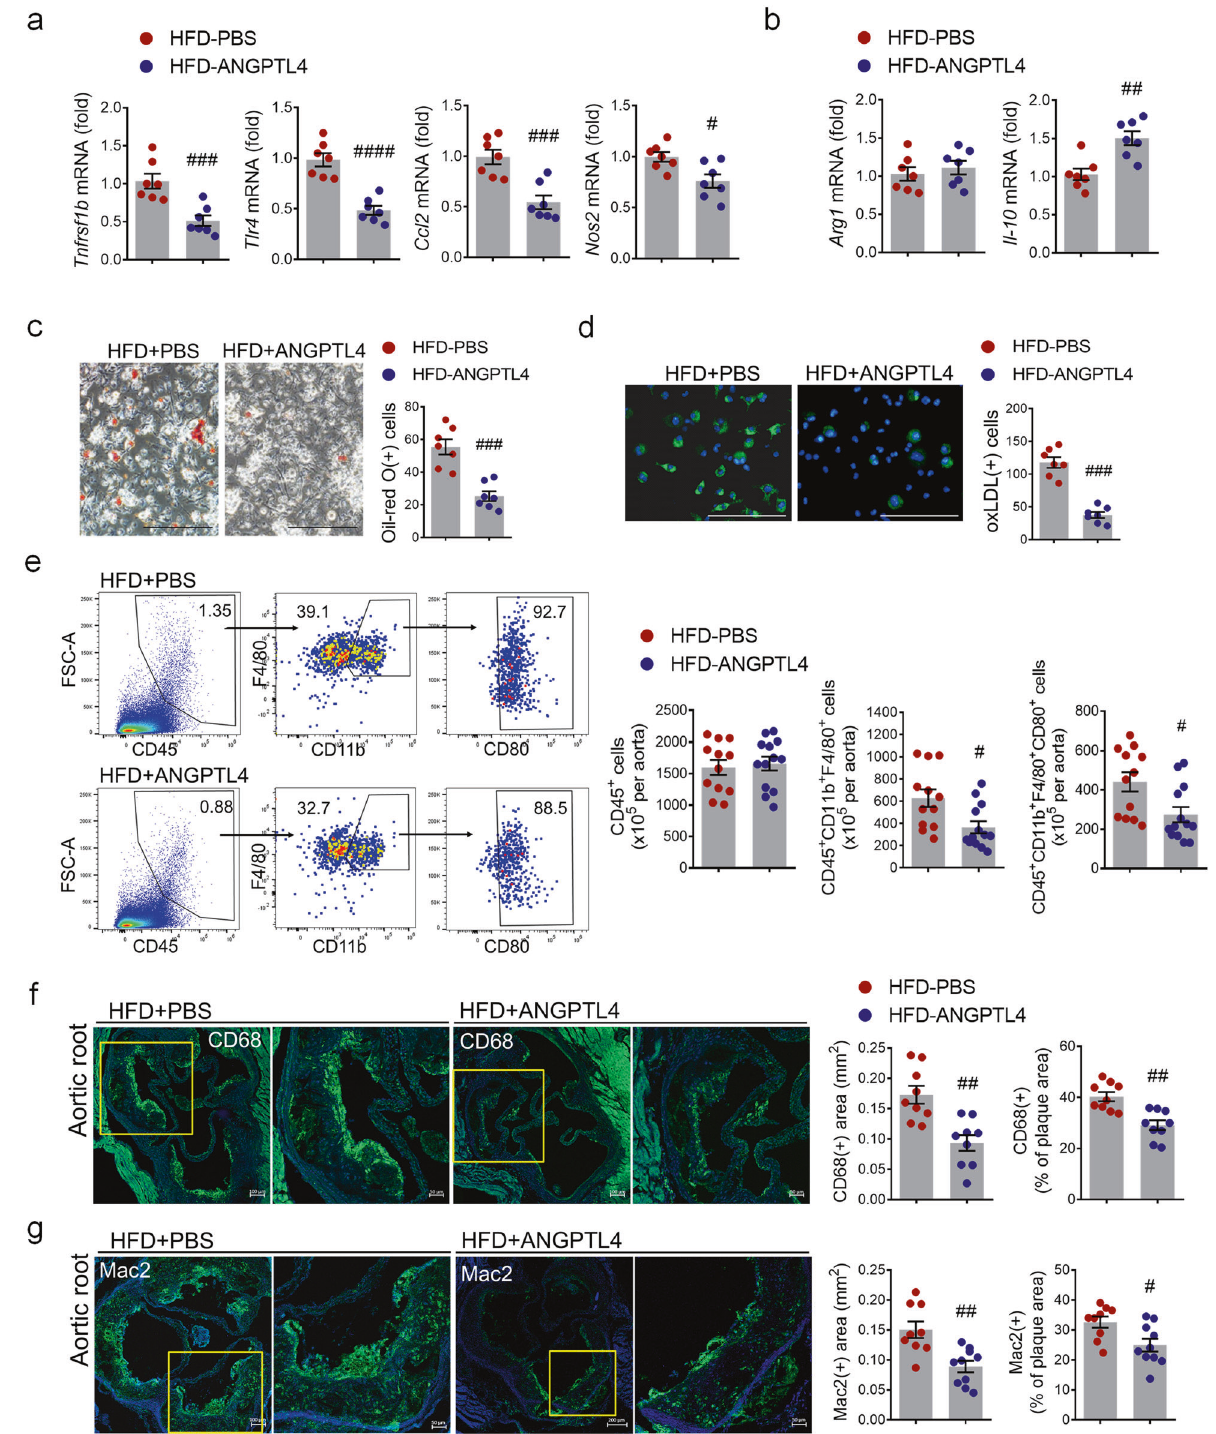
Fig. 2 Effects of ANGPTL4 on macrophage function in atherosclerosis. a , b Proin fl ammatory and anti-in fl ammatory gene expression were analyzed by real-time PCR in BMDMs isolated from Apoe − / − mice treated with PBS or ANGPTL4. c BMDMs from the PBS and ANGPTL4 groups were analyzed using Oil red O staining. Scale bar, 200 μ m. d BMDMs from the PBS and ANGPTL4 groups were treated with oxLDL-DyLight 488 for 24 h, and then oxidized LDL uptake was analyzed. Scale bar, 200 μ m. e Flow cytometry analyses of single-cell aortic suspensions isolated from the PBS and ANGPTL4 groups. In fl ammatory macrophages were quanti fi ed by the number of CD80 + cells among the CD45 + F4/ 80 + CD11b + population. f , g The content of macrophages in aortic root sections from the two groups was determined by immunohistochemical staining with anti-CD68 antibody ( f ) and anti-Mac2 antibodies ( g ). Representative images are shown, and CD68- positive areas ( f ) and Mac2-positive areas ( g ) were measured and quanti fi ed as a percentage of the plaque area. Data were presented as the mean ± SEM. # p < 0.05, ## p < 0.01, ### p < 0.001, #### p < 0.0001 (by Student ’ s t